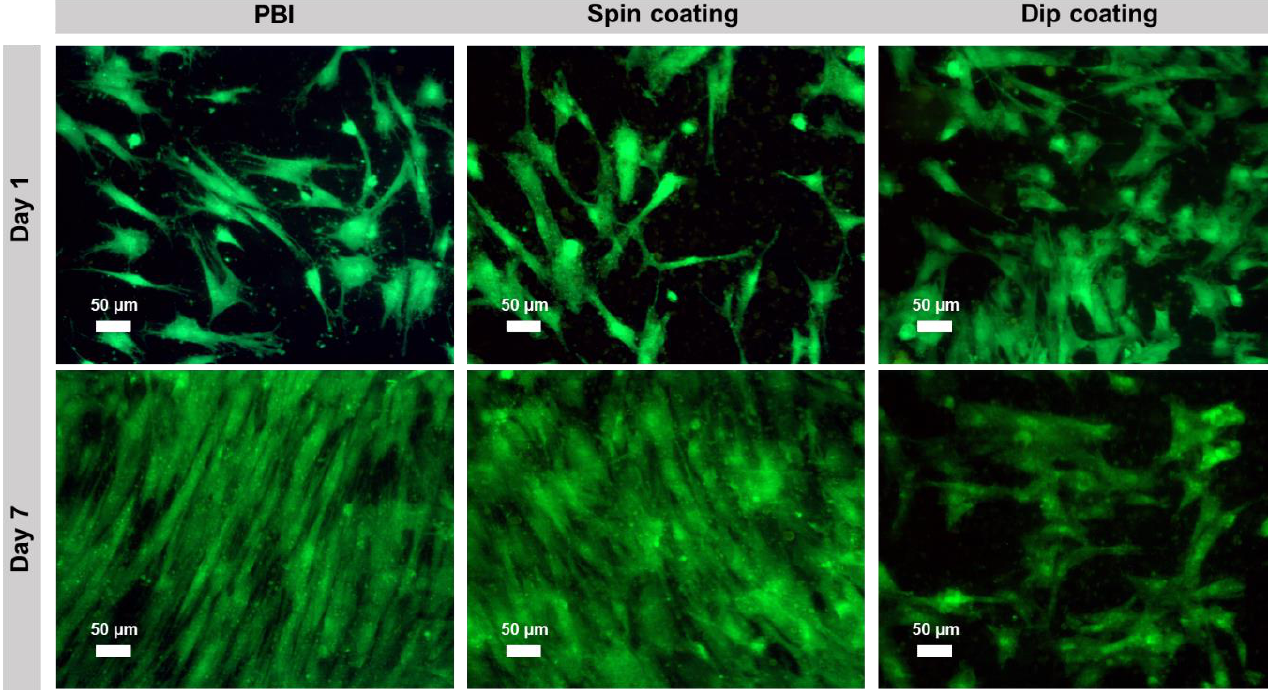
Figure 4. Calcein fluorescence staining of hBM-MSCs cultured on pristine electrospun PBI, PEDOT:PSS-spin coated PBI fibers and PEDOT:PSS-dip coated PBI fibers at days 1 and 7. Viable cells are stained in green. Scale bar: 50 μm.